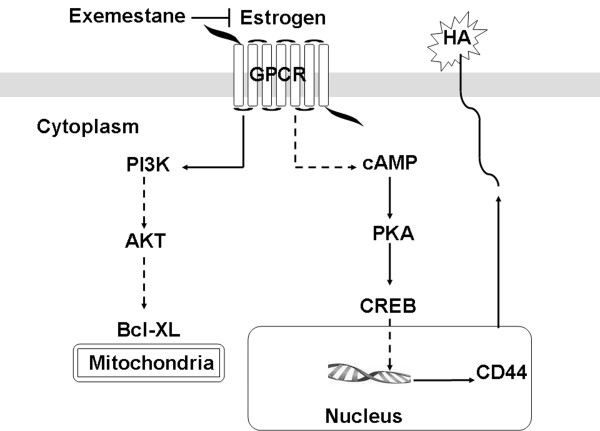
Hypothesized mechanism of action of exemestane on MPM cells. The GPCR receptor binds estrogen and cause estrogen-mediated cAMP stimulation and PI3K cascade. PI3K phosphorylates AKT (pAkt) which in turn regulates Bcl-xL, anti-apoptotic protein. cAMP stimulates PKA, which in turn activates CREB that translocates into the nucleus and acts as a transcription factor for CD44. The action of exemestane is carried out by reducing the levels of estradiol, its binding with GPCR and related downstream pathway.